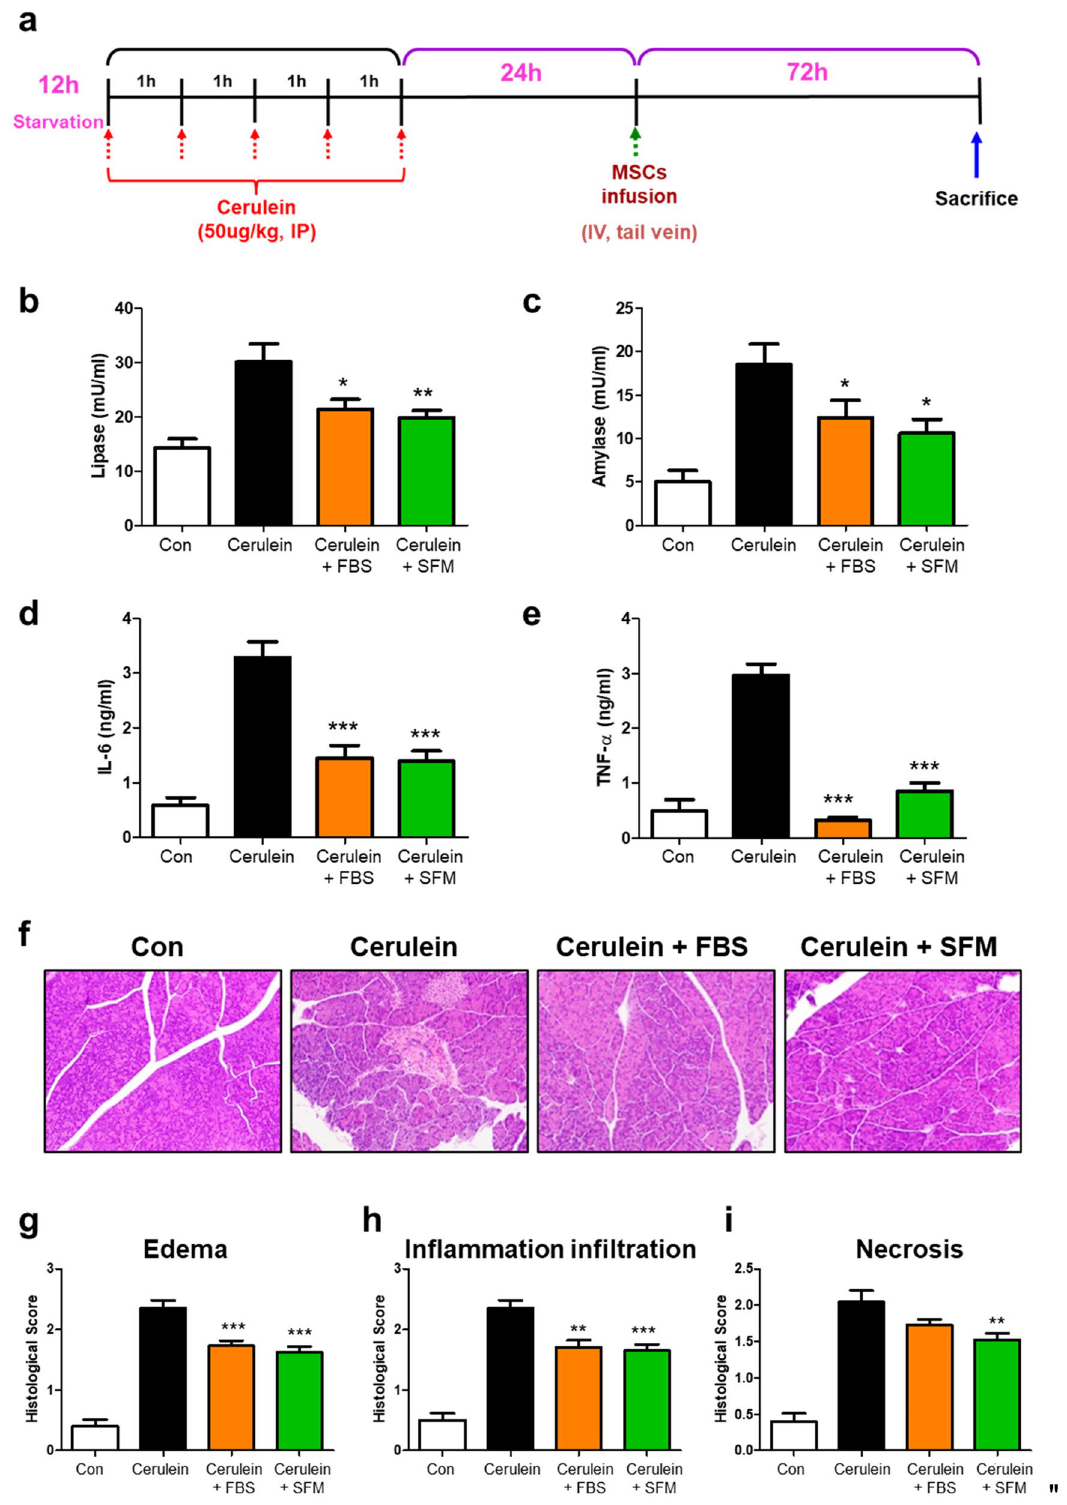
Figure 5. Effects of ADSCs in cerulein induced pancreatitis in mice. ( a ) Acute pancreatitis was induced by cerulean administered five times. After 24 h, ADSCs were infused to investigate their therapeutic efficacy. ( b , c ) Activities of lipase and amylase were significantly decreased after ADSC infusion. ( d , e ) Inflammatory cytokines (IL-6 and TNF-α) were significantly decreased after ADSC infusion, as detected by ELISA. Edema formation, inflammation infiltration, and necrosis were evaluated by histologic analysis. ( f ) Representative image of mouse pancreas after H&E staining. ( g–i ) Histologic changes in pancreas isolated on day 4 after last cerulein injection. Data are represented as the mean ± SEM. * vs. cerulein-only injection group * p < 0.05, ** p < 0.01, *** p < 0.001. ADSC adipose-derived stem cell, MSC mesenchymal stem cell, Con control, FBS fetal bovine serum, SFM serum free